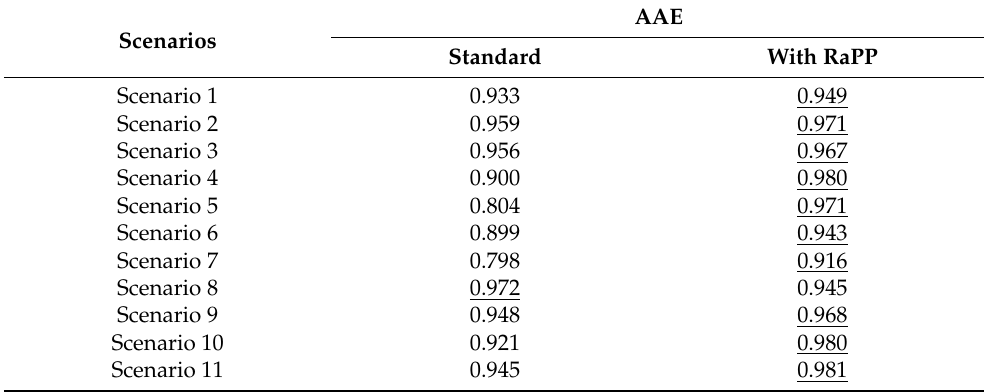
Table 5. AUROC with novelty